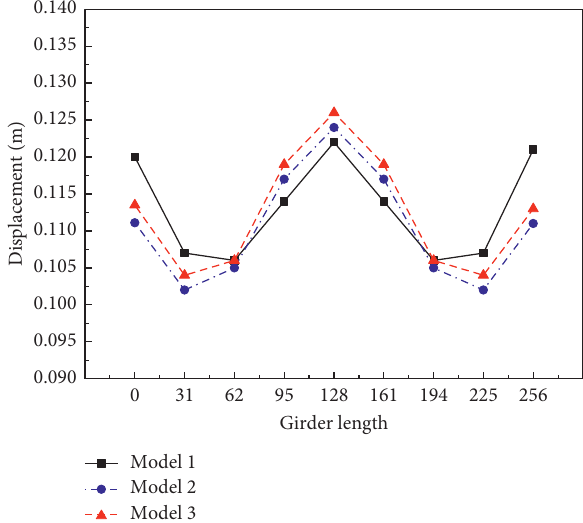
Figure 9: The peak displacement of key positions of the